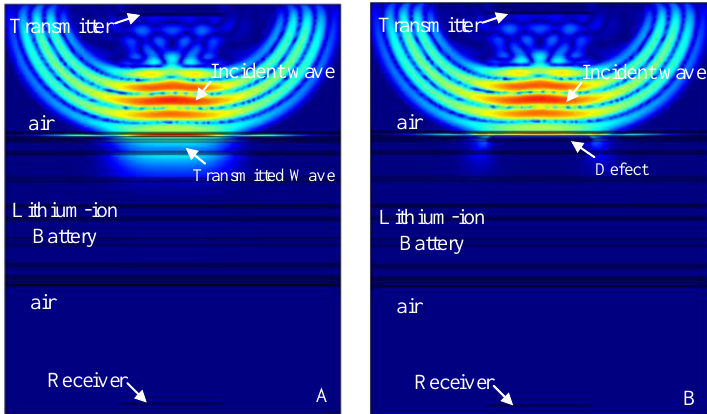
Figure 11. Finite element simulation of time snapshots of the propagation of the ultrasonic wave in the lithium-ion battery (11.268 µ s). ( A ) The simulation result without a defect; ( B ) the simulation result with a stomata defect in the first electrolyte layer.